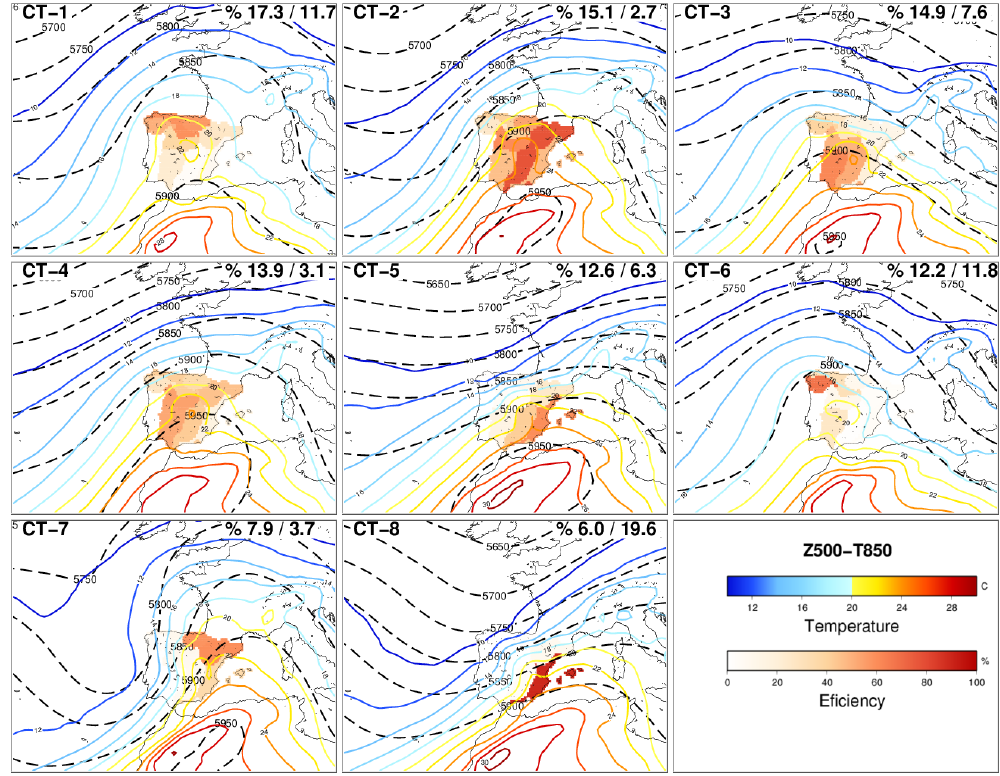
Figure 4. Same as Fig. 3 but for the Z500–T850 classification. Z500 and T850 are represented by geopotential high contour levels (shaded black lines) and isothermals (colour